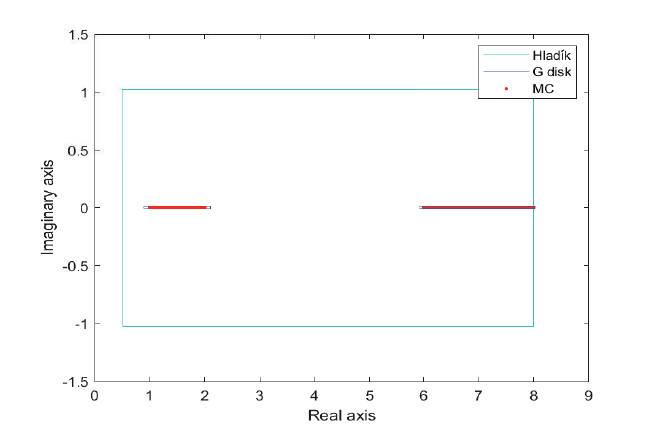
Fig. 1. Eigenvalue set and enclosures of Example 1.